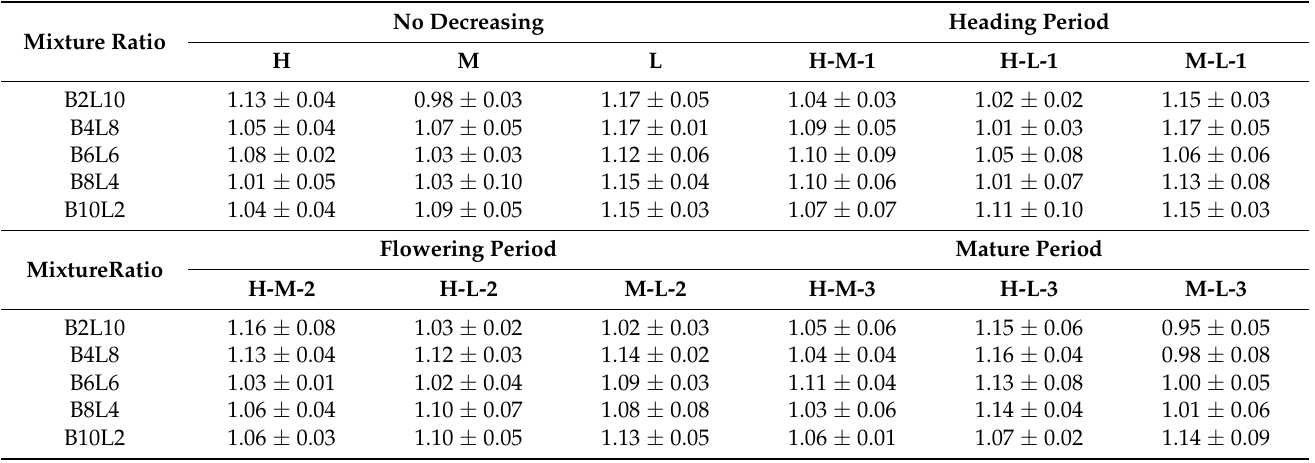
Table 4. Relative yield total (RYT; mean ± SD) for total biomass production in the mixtures